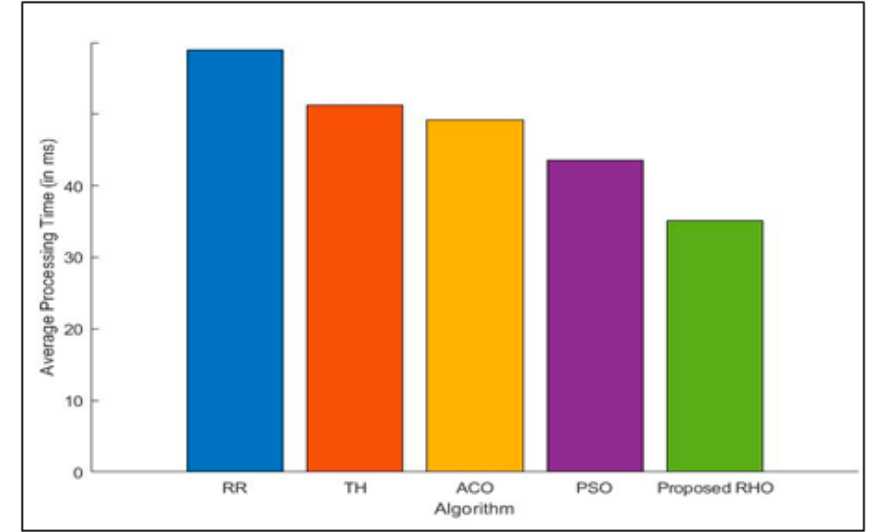
Figure 6. Average Processing Time for different algorithms.